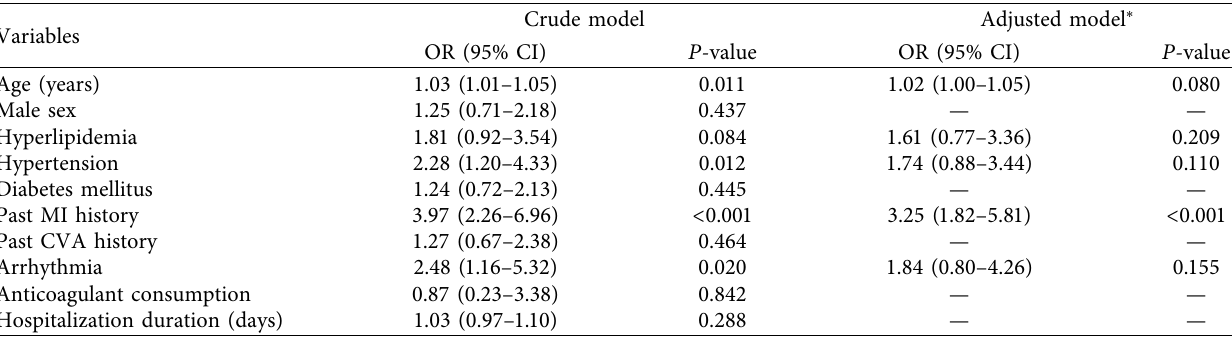
Table 2: Association of demographic and risk factor variables with heart failure in logistic regression analysis among ischemic stroke